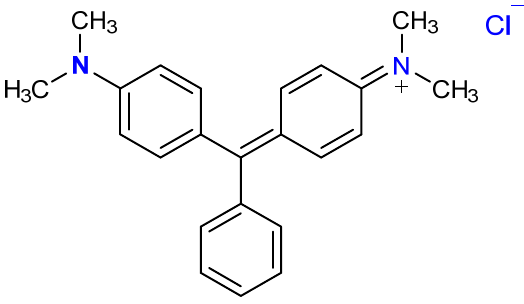
Figure 1. Chemical structure of Malachite Green.